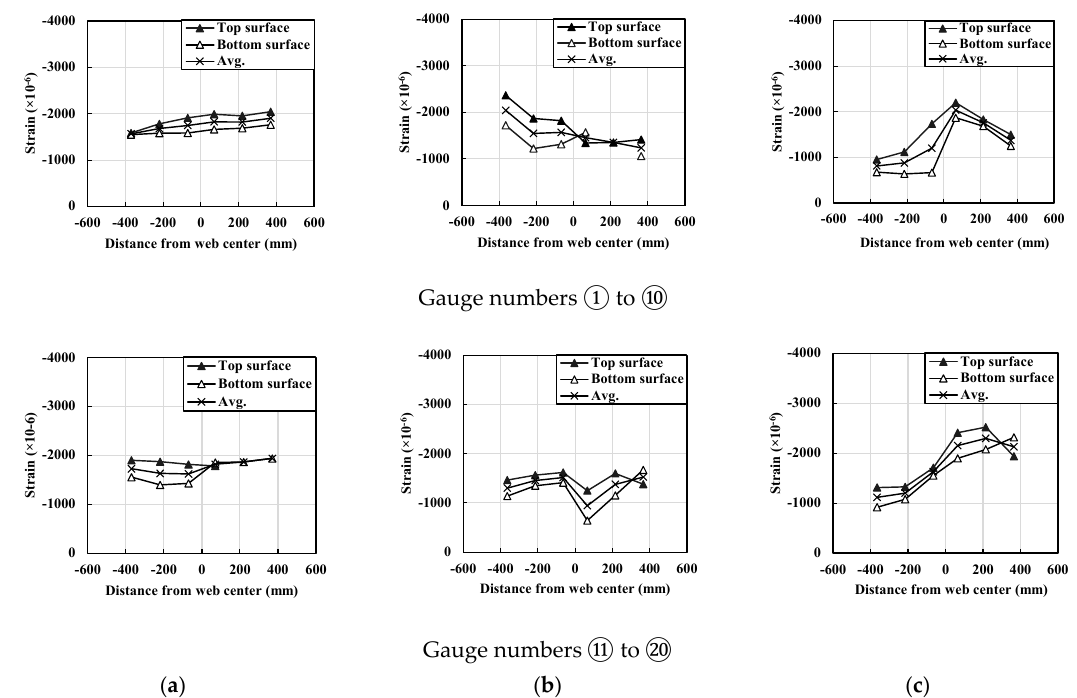
Figure 17. Compressive strain distributions in the longitudinal direction of UHPFRC flanges: ( a ) specimen #1, ( b ) specimen #2, and ( c ) specimen #3 (data from reference [23]). Table 6. Comparisons between average strain ( ε avg ) and maximum material strain ( ε cu ) (data from reference [23]). Specimens